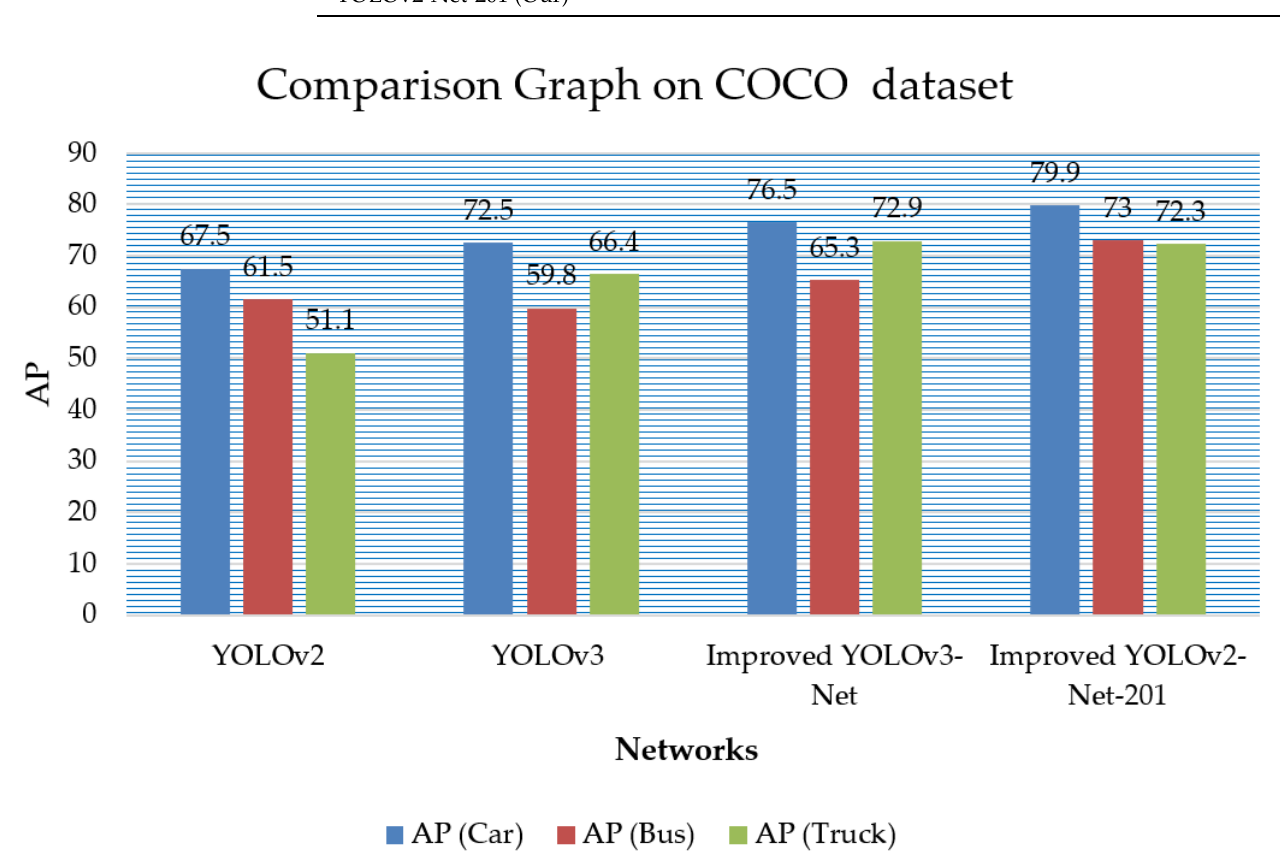
Figure 10. Comparison Graph with existing models for Car, Bus, and Truck samples using the COCO dataset.